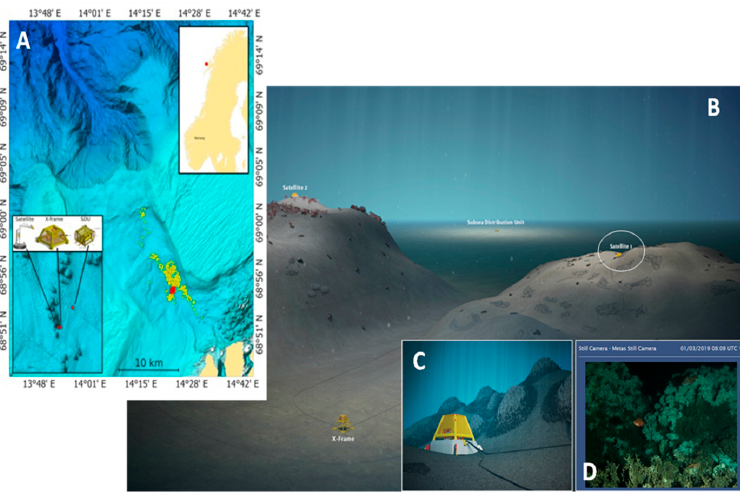
Figure 1. Overview of the study area where the Lofoten-Vesterålen (LoVe) observatory is located: ( A ) Bathymetric map of the canyon area showing (in red) the observatory area and (in yellow) relevant Desmophyllum pertusum reef mounds around it (adapted from [24]), ( B ) three-dimensional (3D) detailed representation of the area showing (encircled in white) the video node providing the footage used to train AI procedures, ( C ) enlarged view of the areas surrounding the node where D. pertusum reefs are schematized, and finally ( D ) the field of view as it appears in the analyzed footages (B, C, and D) taken from the observatory site at https://love.statoil.com/.